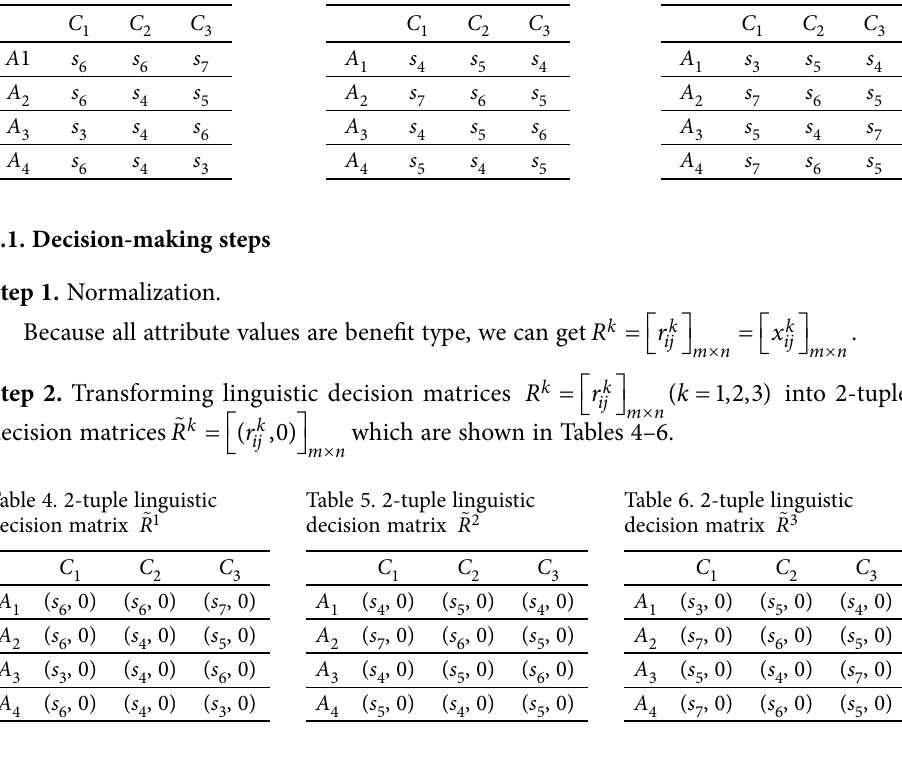
Table 3. Linguistic decision matrix X 3